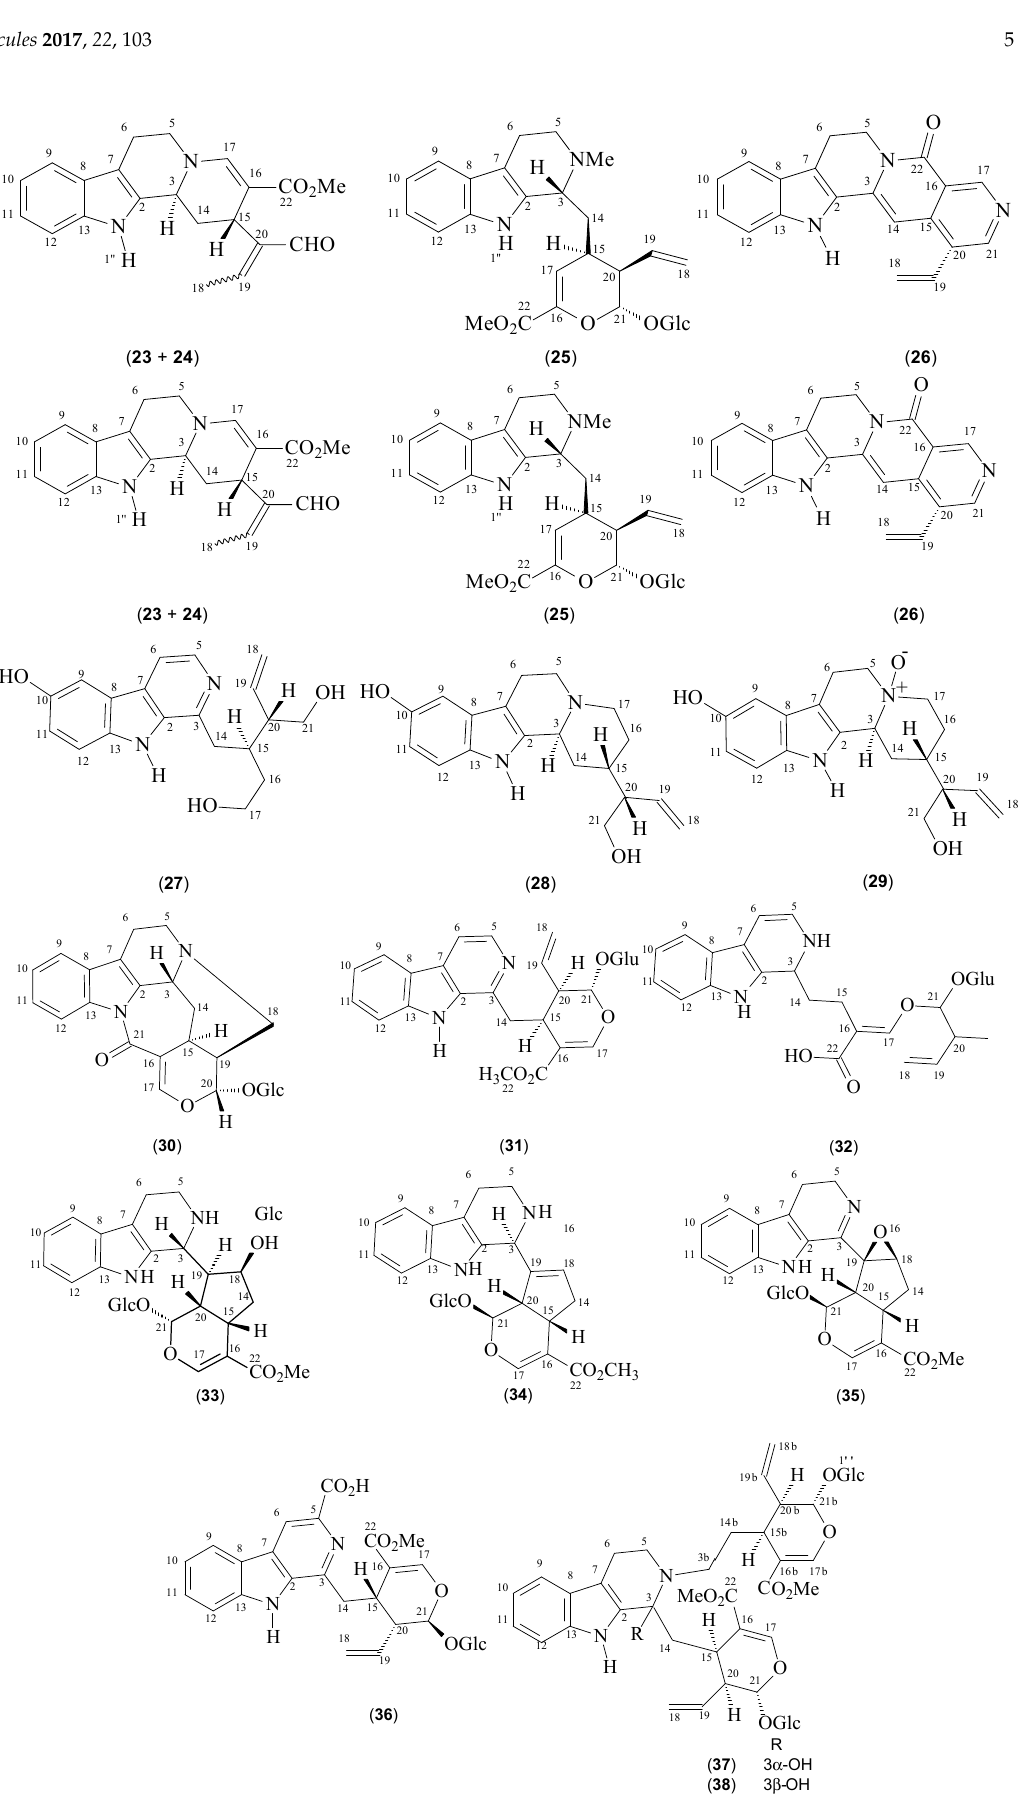
Figure 1. Structures of monoterpene indole alkaloids from Psychotria species.